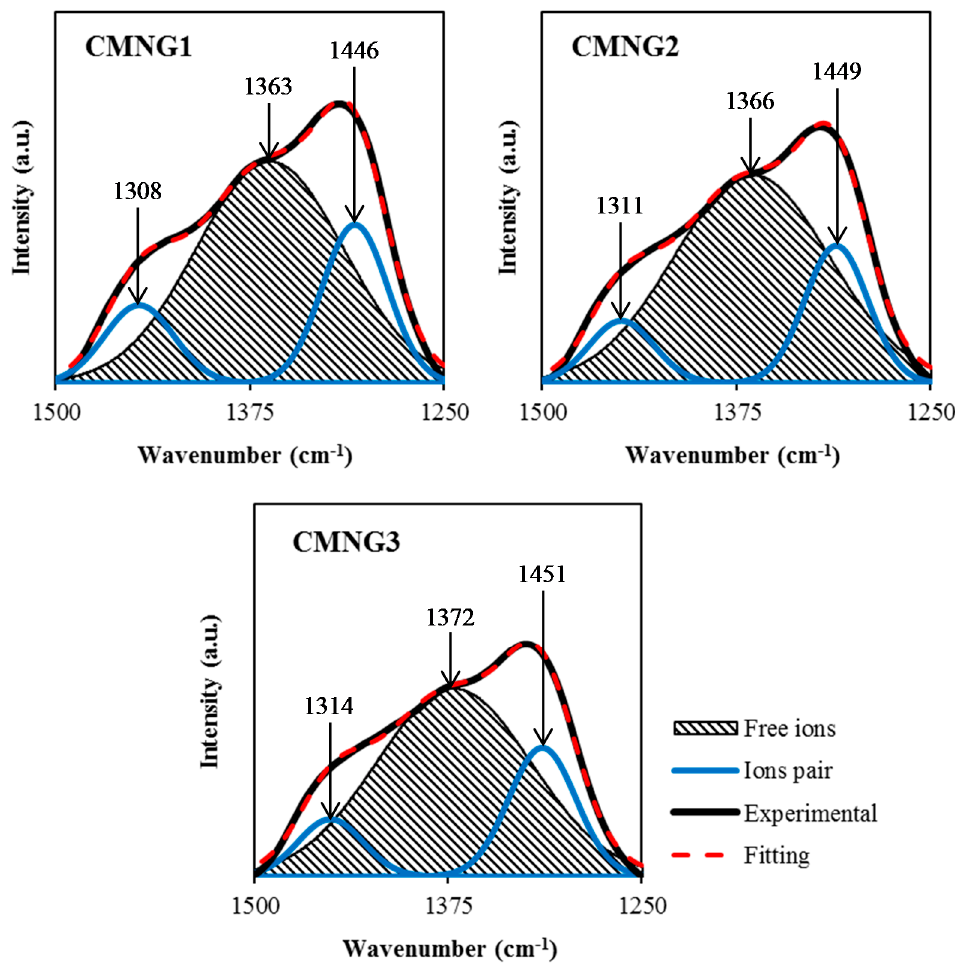
Figure 5. Deconvolution of FTIR spectra at 1250–1500 cm − 1 .